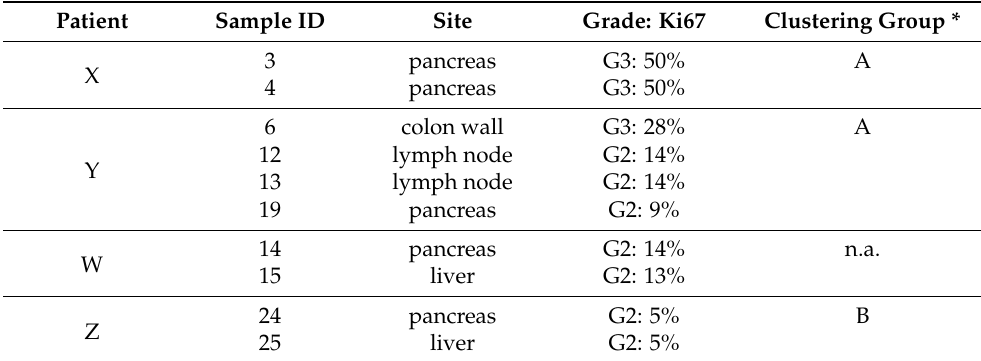
Table 2. Four PanNET patients with multiple samples